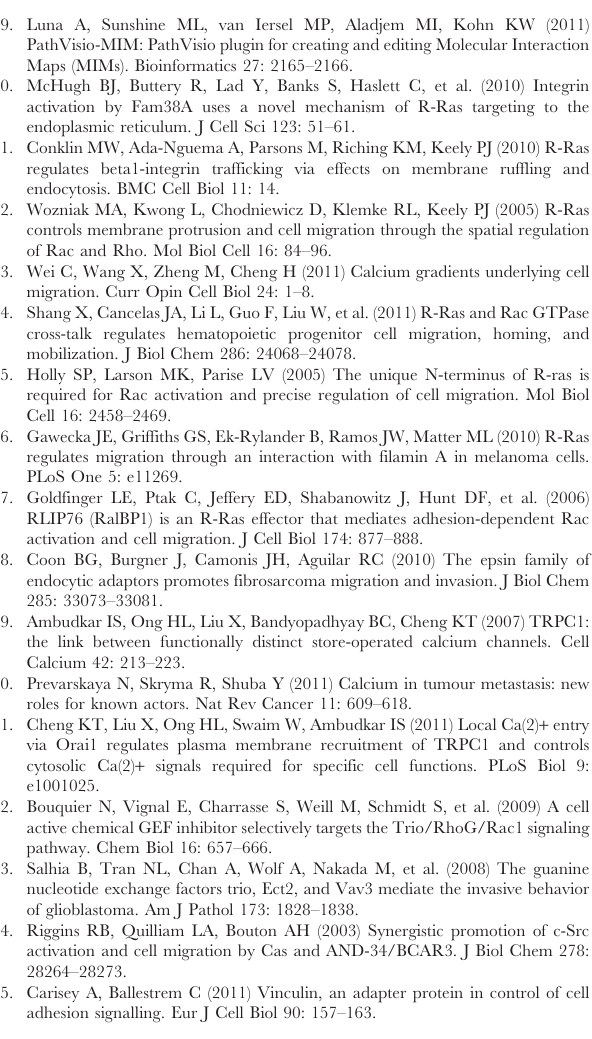
Figure S1 Extended high cross-correlation gene set HCCS66. These 66 genes were selected on the basis of correlated expression with the HCCS15 genes of Figure 2 (see Methods ). The gene names highlighted in yellow are the genes represented in the definitions are summarized in Figure